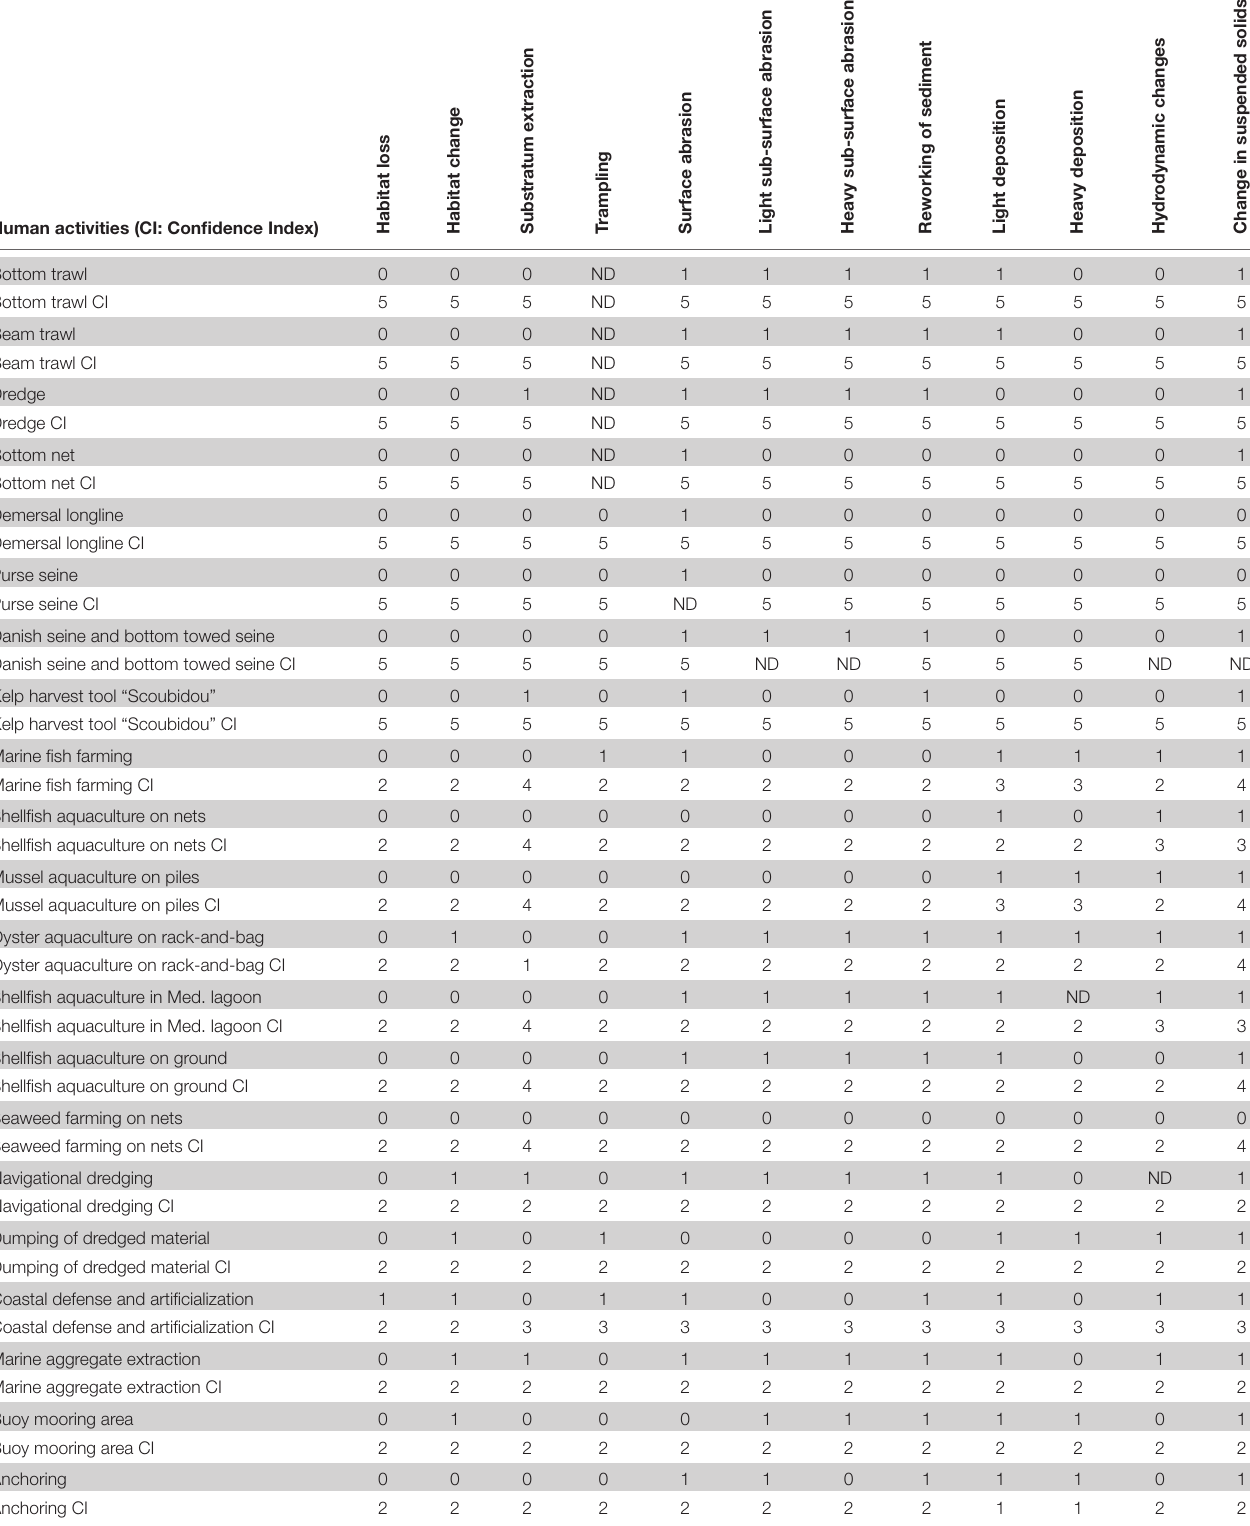
TABLE 1 | Extract of the activities – pressures relationship matrix, for 21 human activities and 12 physical pressures used in the analysis [gray lines: binary relationship (0 or 1) between activities and pressures, white lines: confidence index associated with the relationship evaluation (value between 0 and 5), ‘ND’: undefined]. Physical